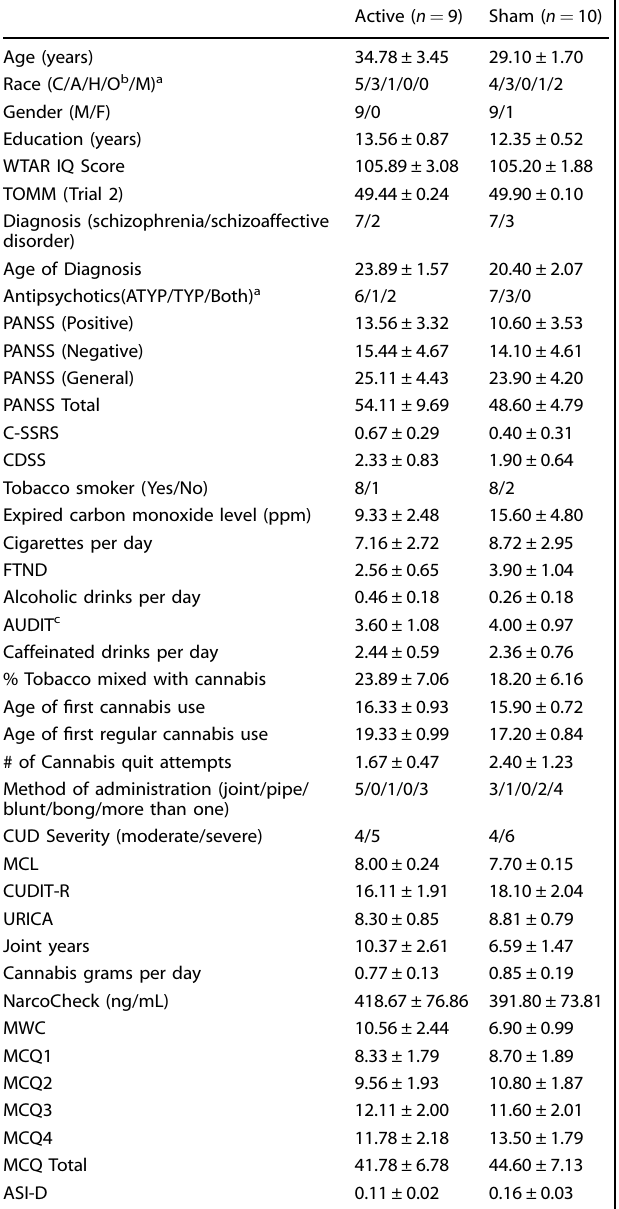
Table 1. Demographic, baseline clinical and substance using